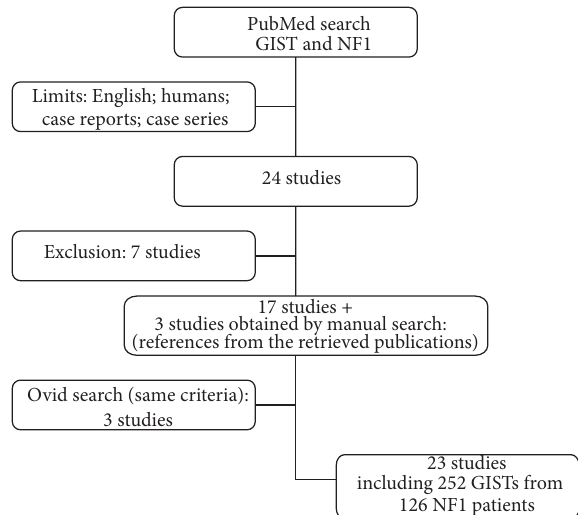
Figure 1: Systematic review: study design according to the PRISMA